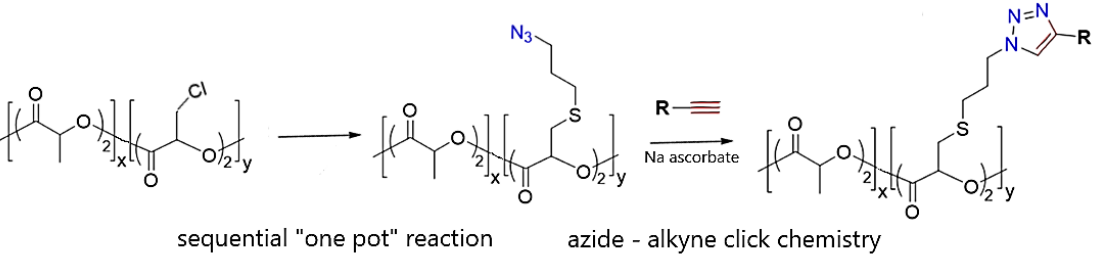
Figure 21. Synthesis of azide-substituted polylactide—based on [341].